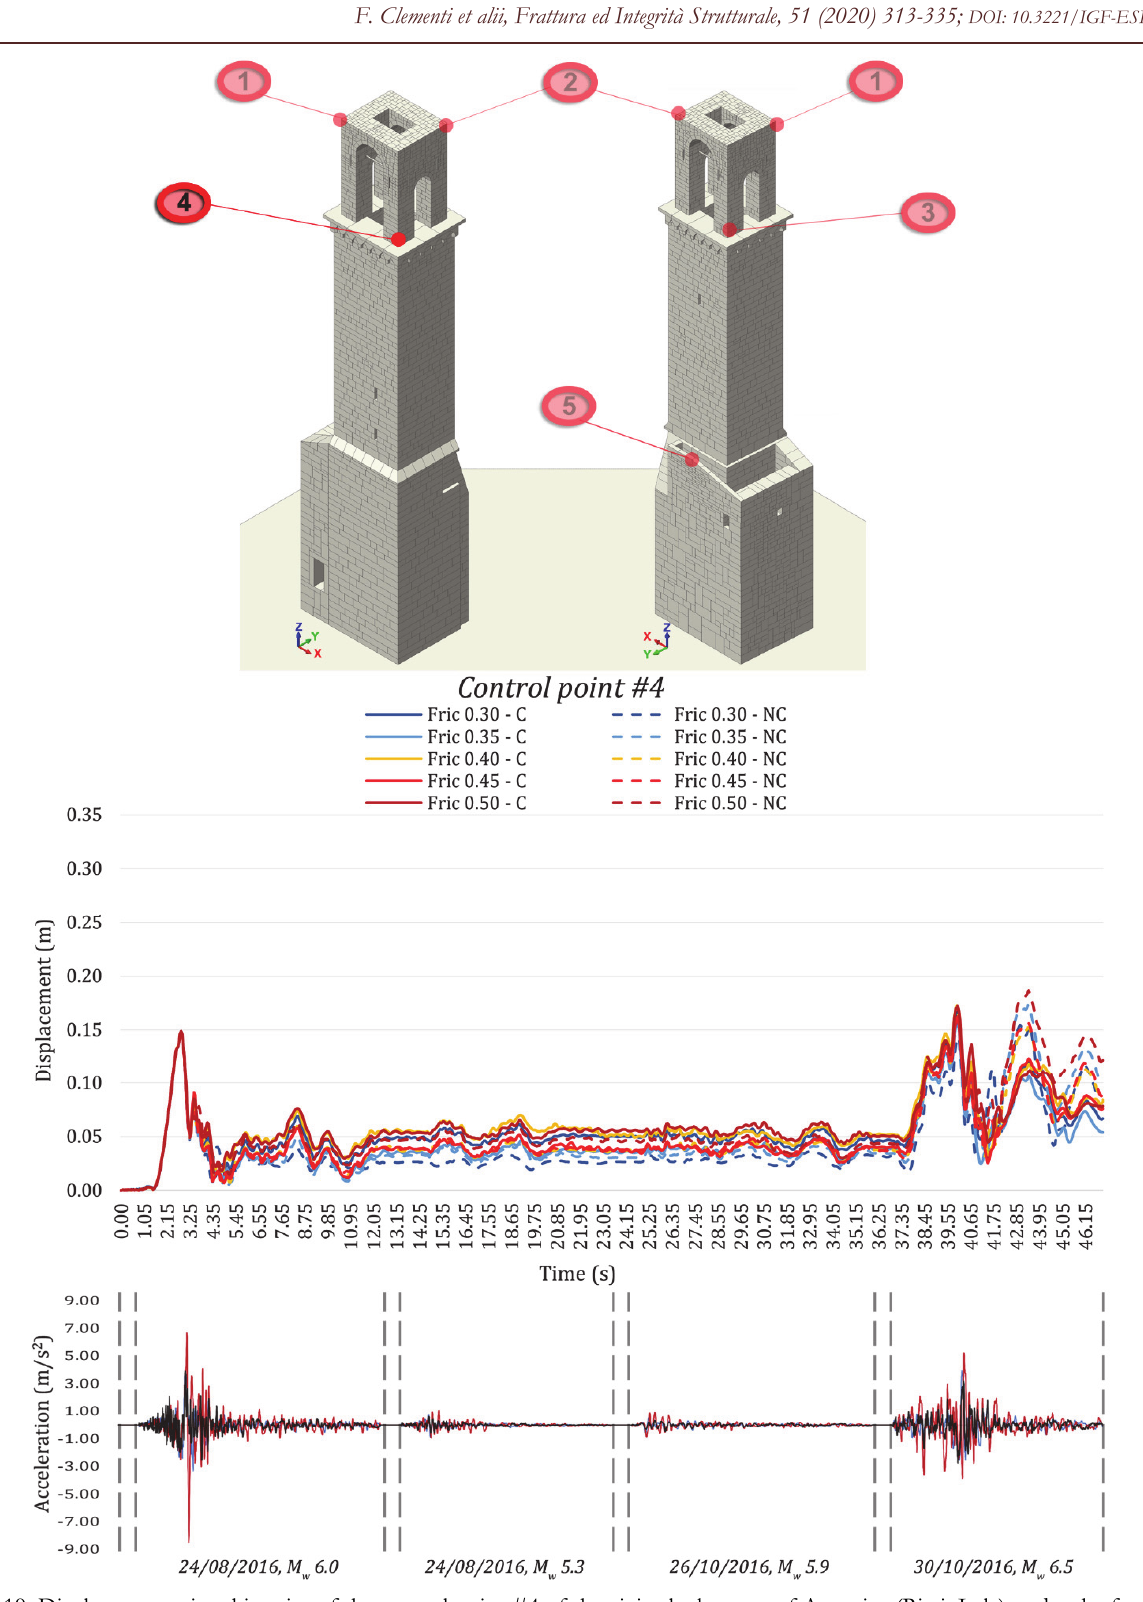
Figure 19: Displacements time histories of the control point #4 of the civic clock tower of Amatrice (Rieti, Italy) under the four main shocks in the three components x,y,z recorded in the village during the Central Italy seismic sequence of 2016 for both configurations, with (namely C) and without (NC) the steel chains, at varying of the friction on the bell